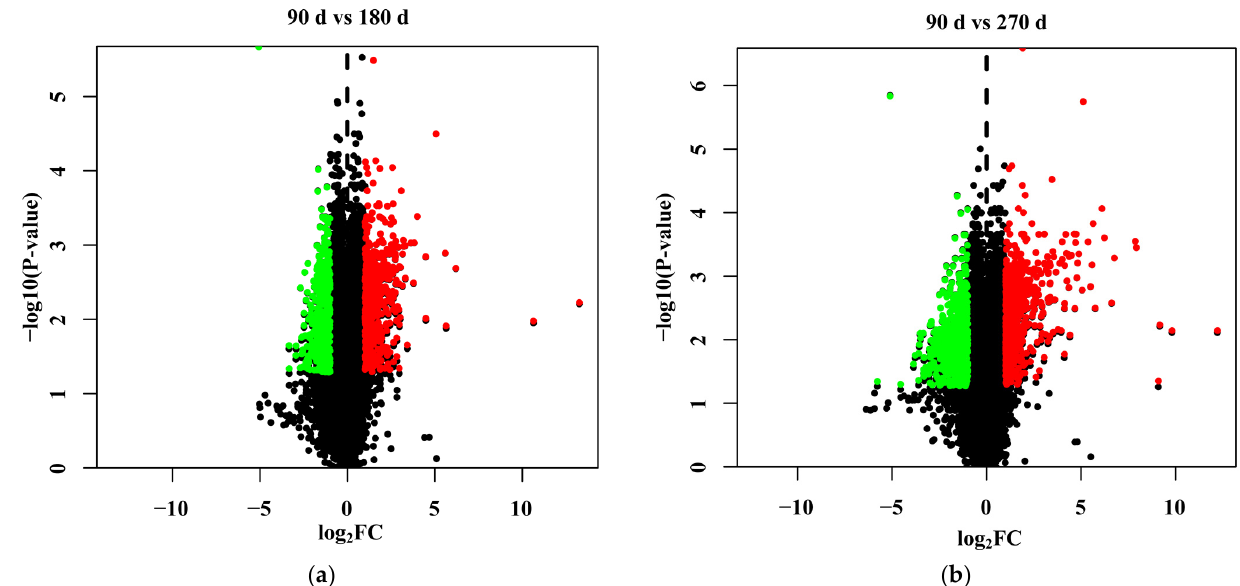
Figure 2. Volcano plot of differentially expressed genes (DEGs). ( a ) Volcano plot of DEGs identified for mid-lactation compared to peak lactation. ( b ) Volcano plot of DEGs identified for late lactation compared to peak lactation.